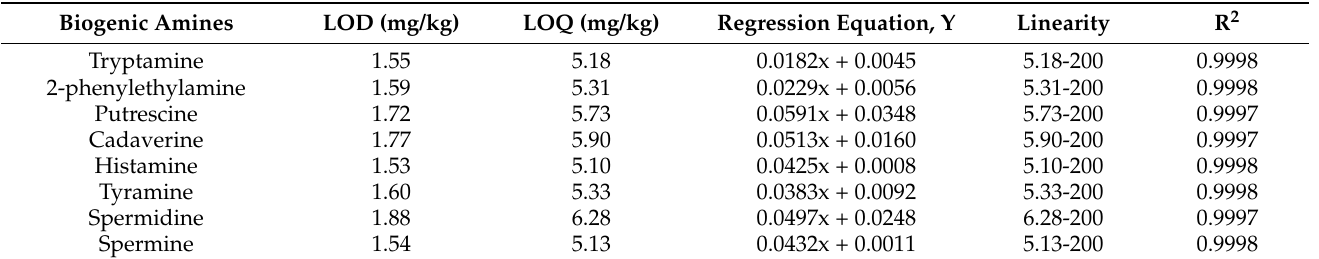
Table 3. Parameters of calibration curves for quantification of biogenic amines and LOD and LOQ values.